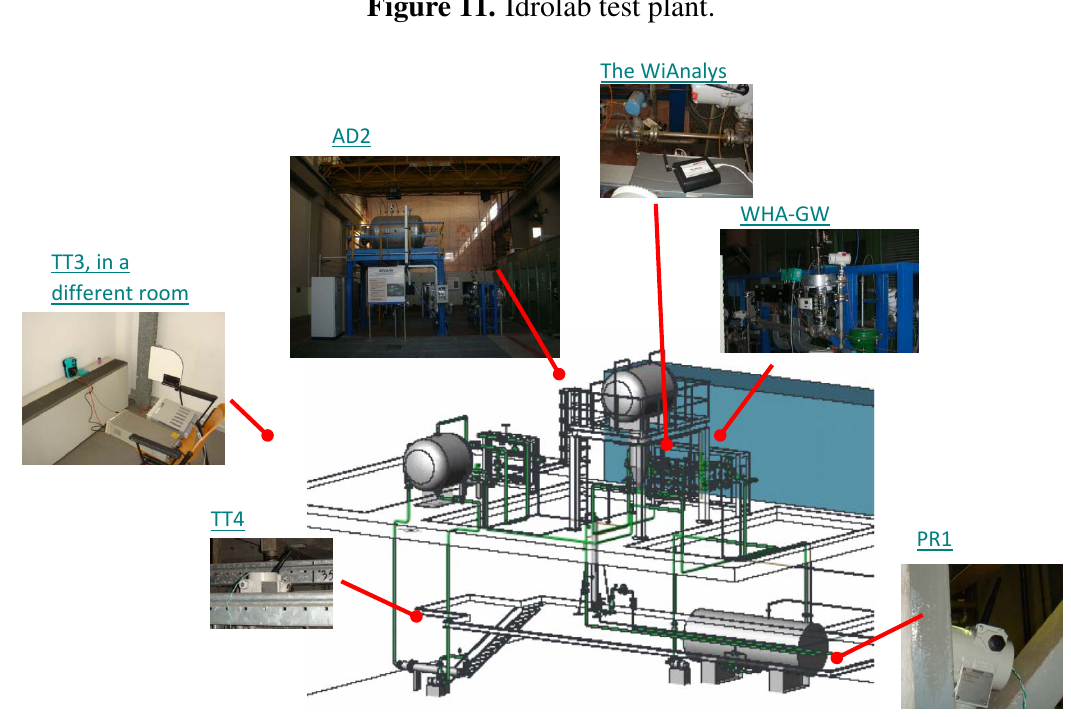
Figure 11. Idrolab test